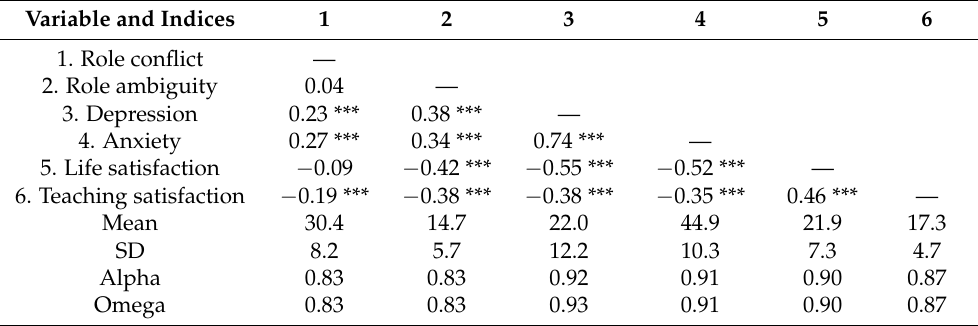
Table 1. Descriptive Statistics, Intercorrelations between, and Reliabilities of, Study